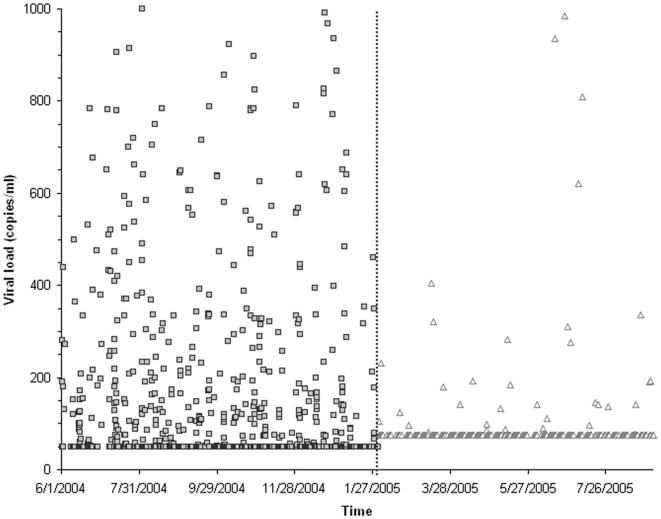
HIV-1 viral loads vs. time.This scatter plot shows each HIV viral load measurement (copies/ml on y-axis) vs. time (x-axis) with a vertical line dividing the RT-PCR (□ per each value) from bNDA (▵ per each value) time periods. In this figure, undetectable viral loads are censored to 49 copies/ml for the RT-PCR period and to 74 copies/ml for the bDNA period.